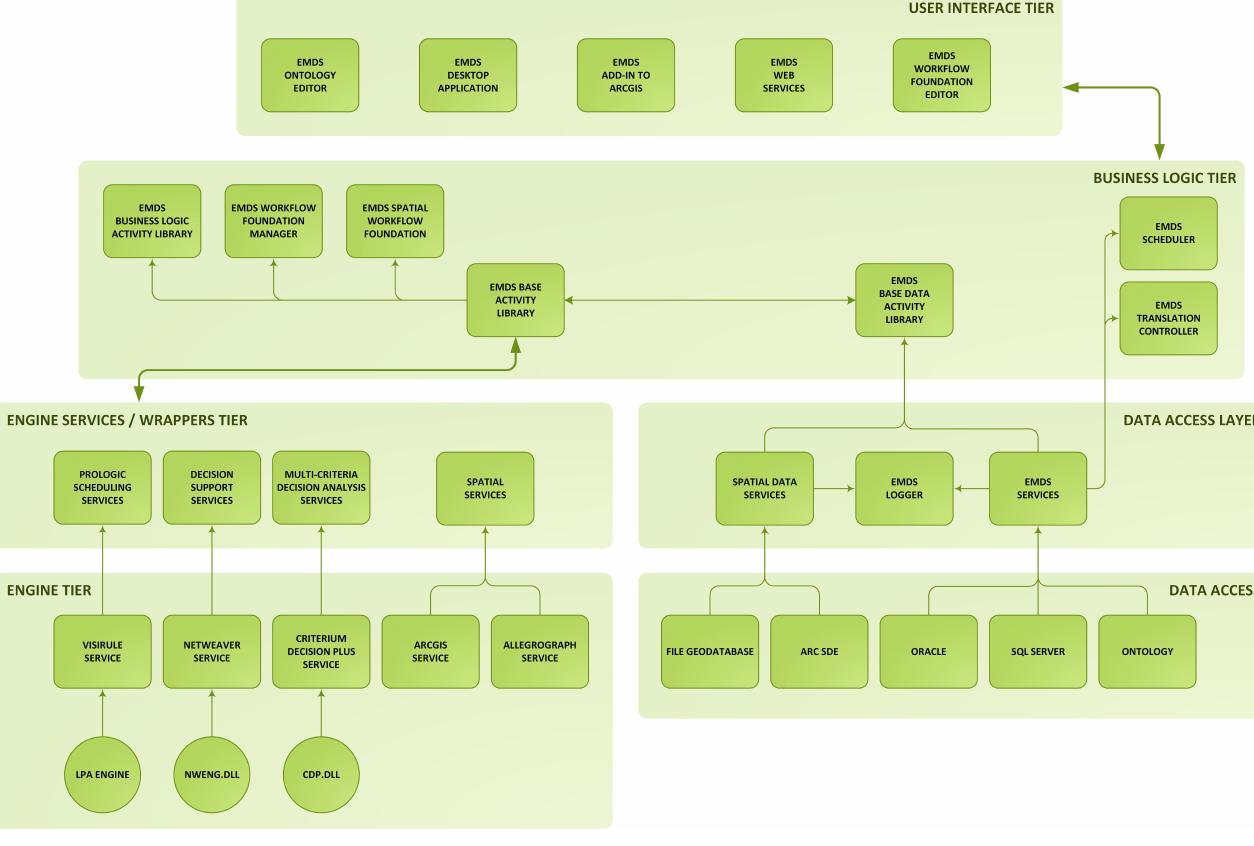
Figure 1. Overview of the EMDS 5 service-oriented